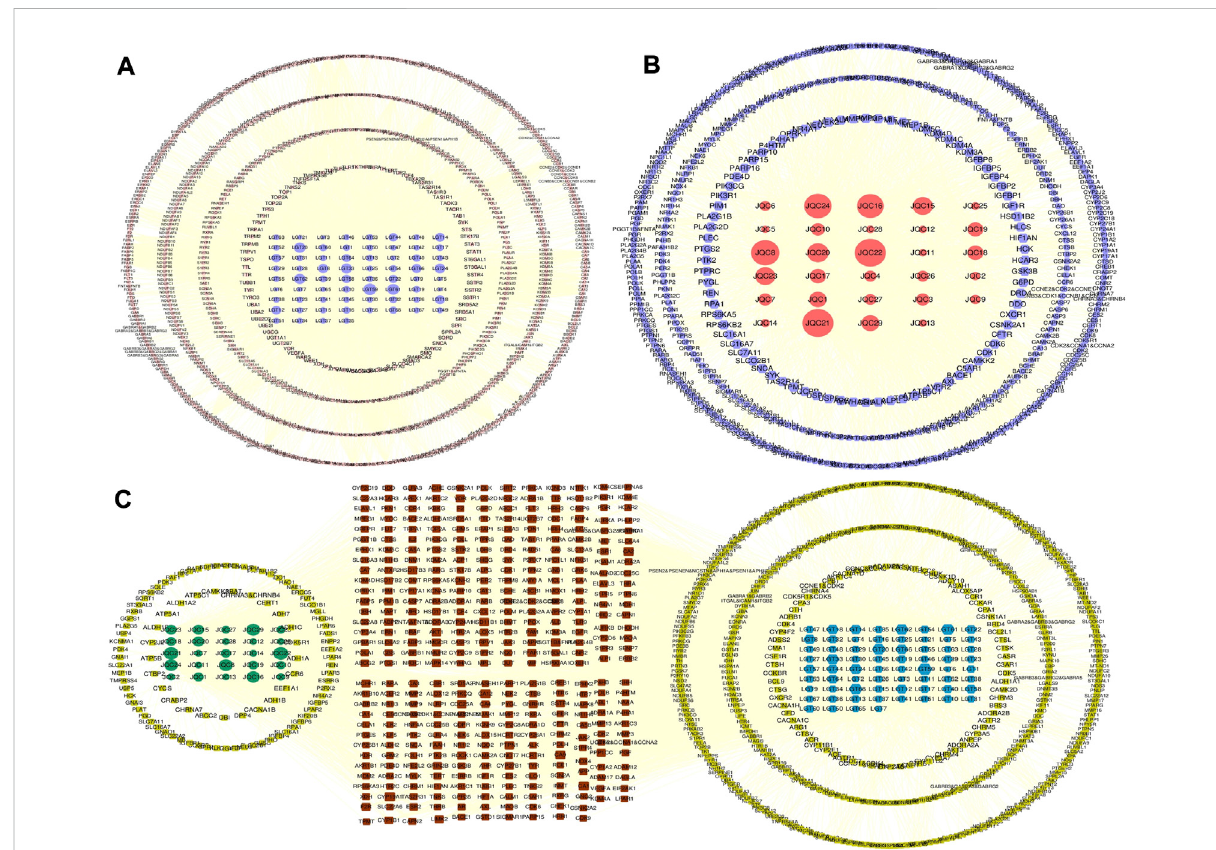
FIGURE 3 The C-T network of LGT and JQC. (A) C-T network of LGT. (B) C-T network of JQC. (C) Common and speci fi c C-T network for LGT and JQC. The blue nodes represent components of LGT. The green nodes represent components of JQC. The red nodes means common targets of LGT and JCQ, and the yellow ones as the speci fi c